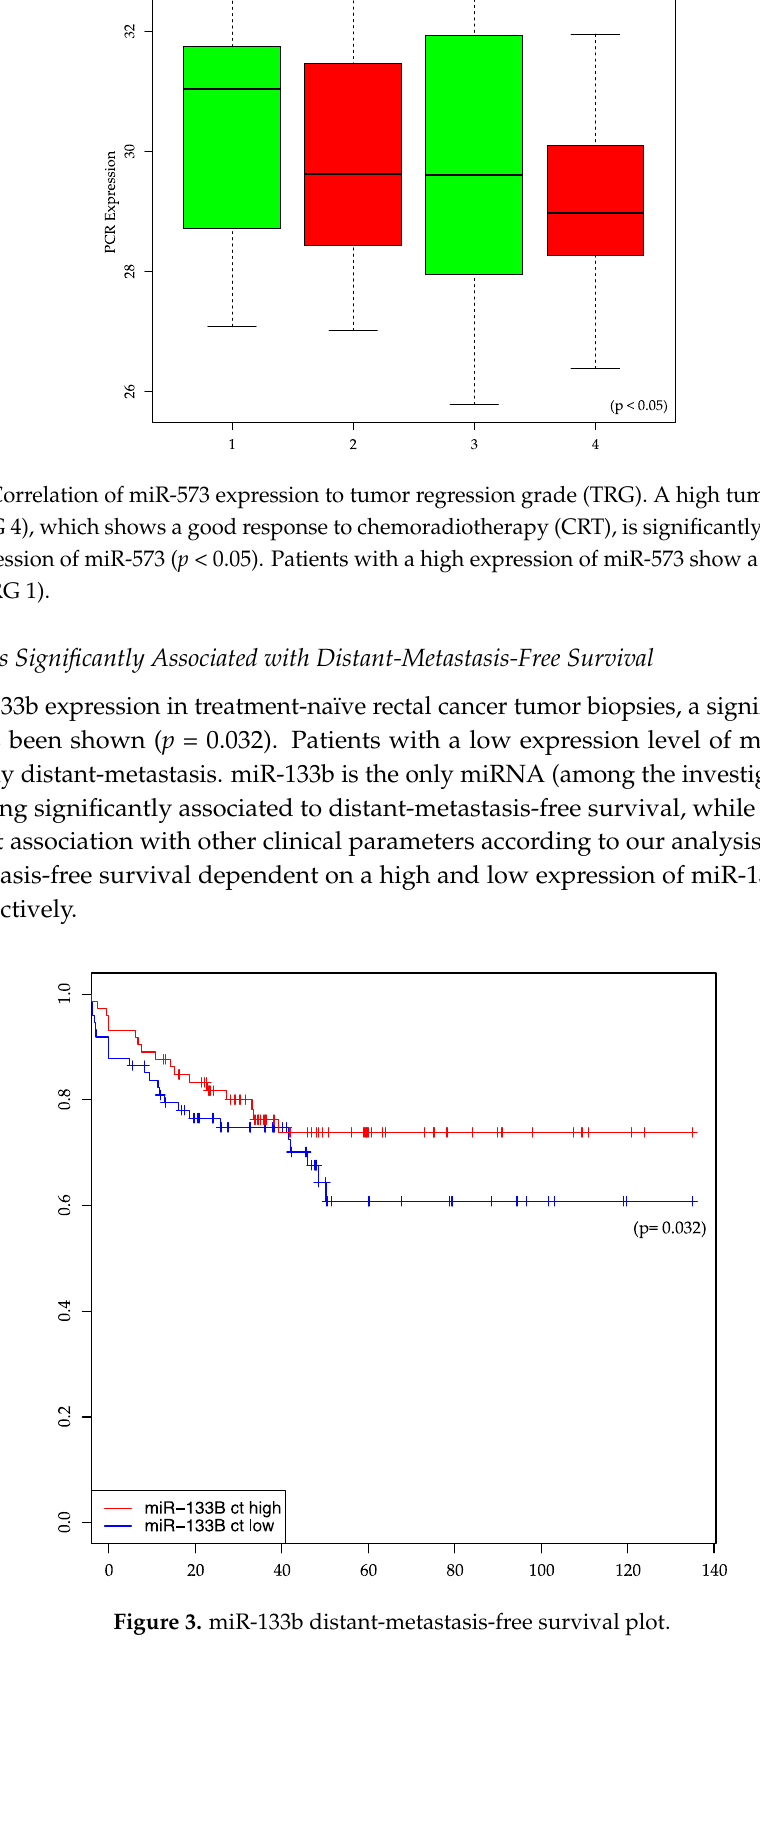
Figure 3. miR-133b distant-metastasis-free survival plot.